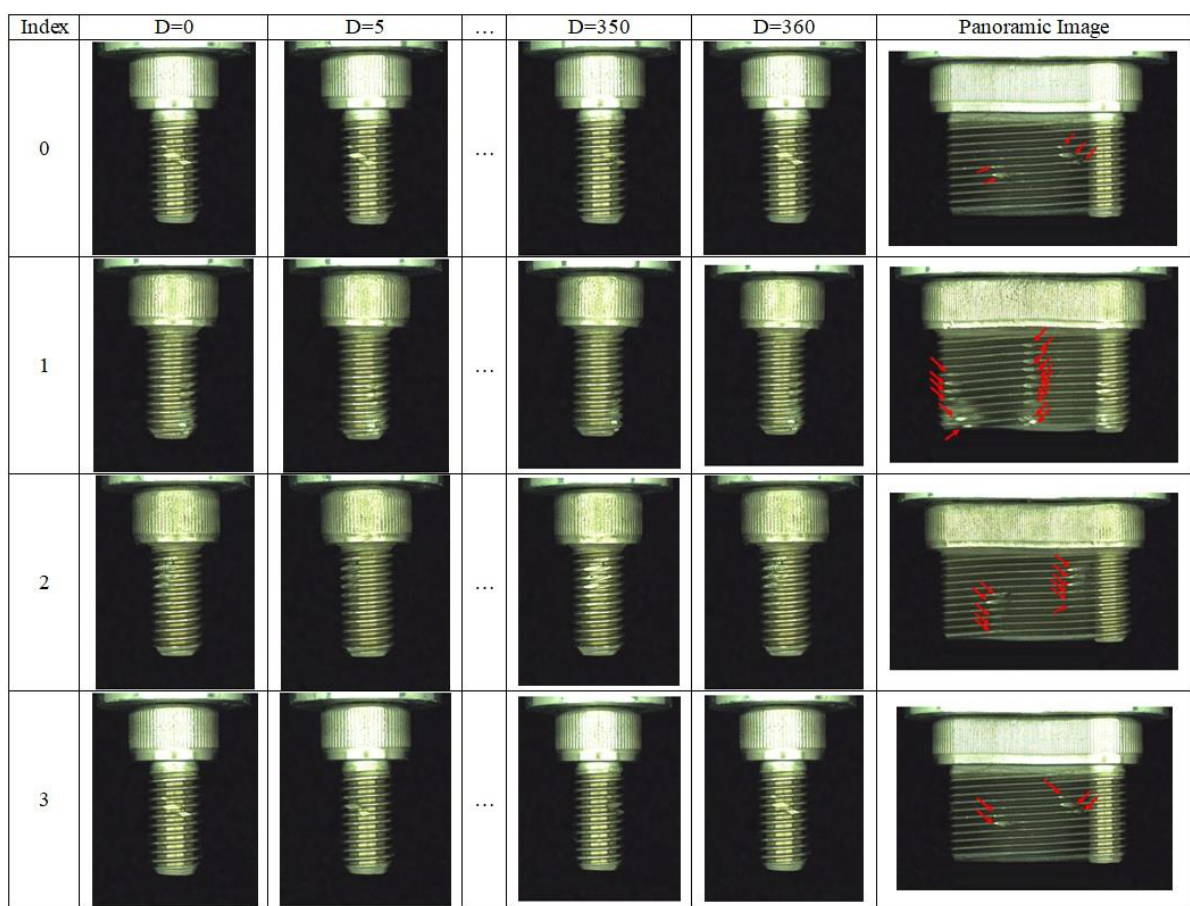
Figure 8. The extended panoramic image with different angles of four screw products (unit: 0.03 mm/pixel).